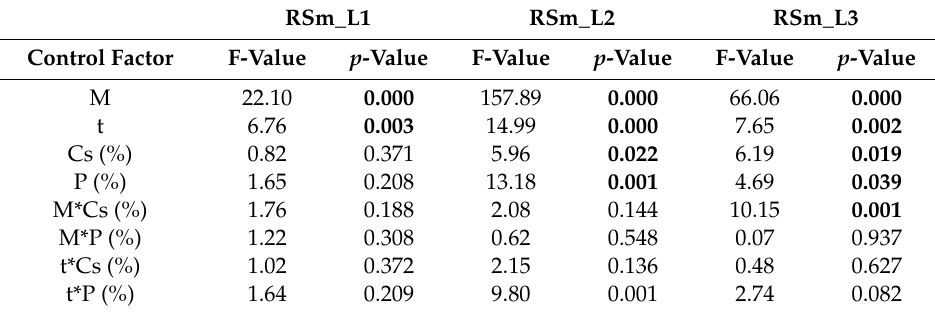
Table 8. ANOVA results for mean width of profile elements, computed F-value and p